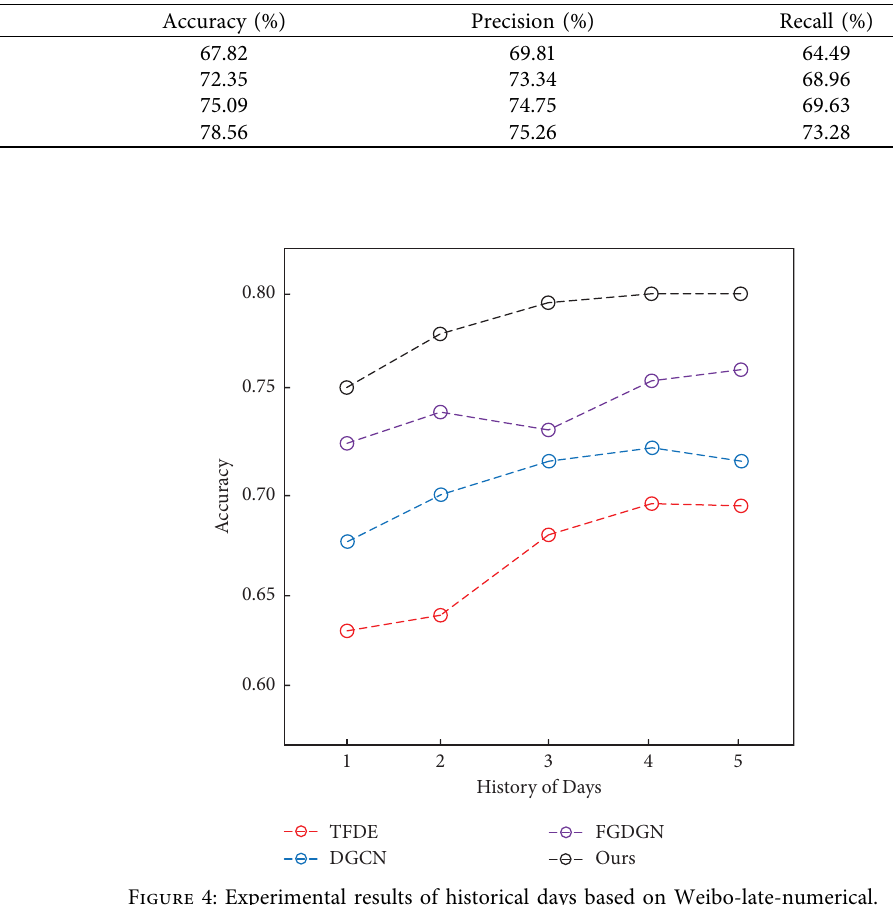
Table 1: Experimental results based on the Weibo-late-numerical dataset.